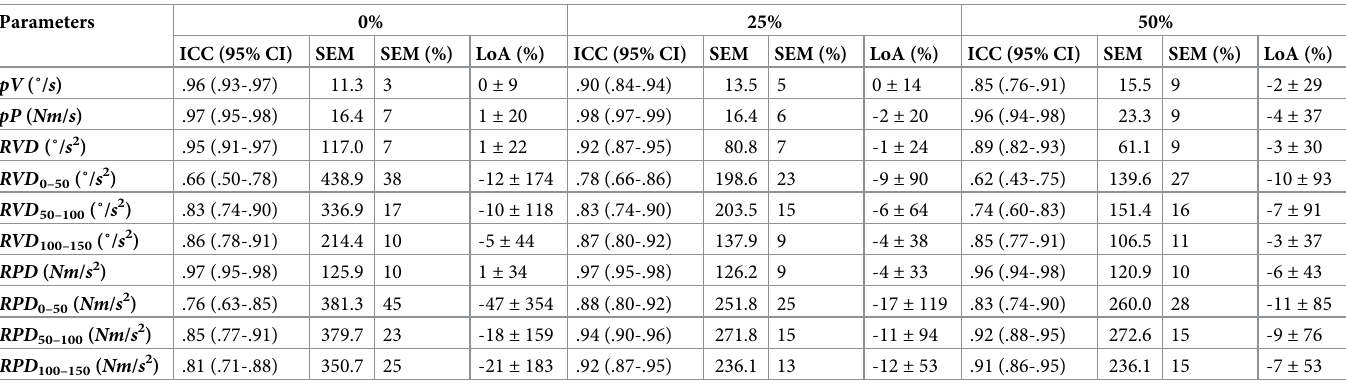
Table 2. Relative and absolute reliability (N = 63 ( ♂ 27, ♀ 36)).